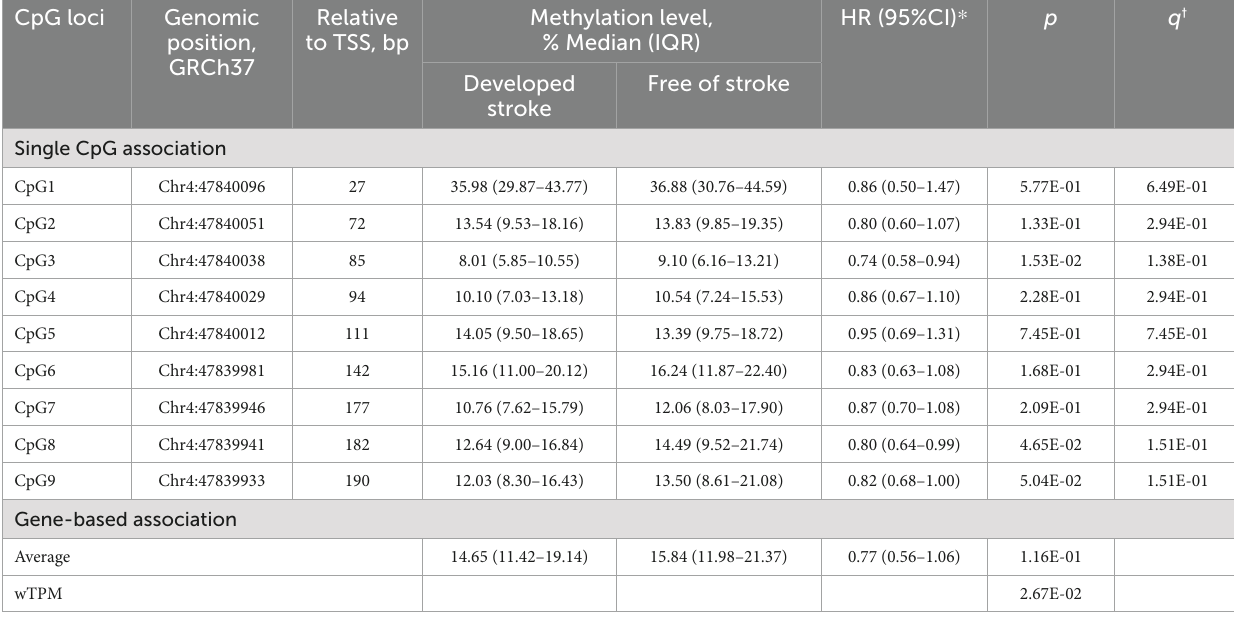
TABLE 3 The prospective association between CORIN promoter methylation and stroke in the replication sample.